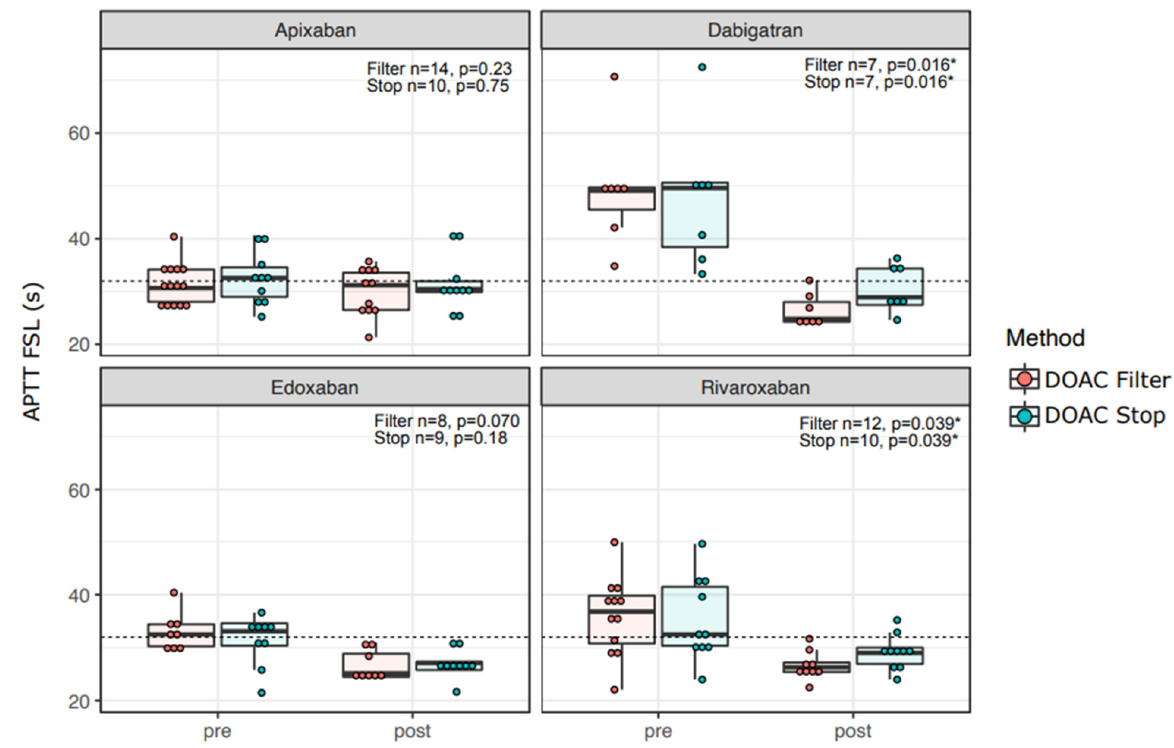
Figure 4. APTT-based screening test clotting times reduce only for samples with dabigatran or rivaroxaban when treated with DOAC adsorbents. APTT-based test screening test (FSL) clotting times